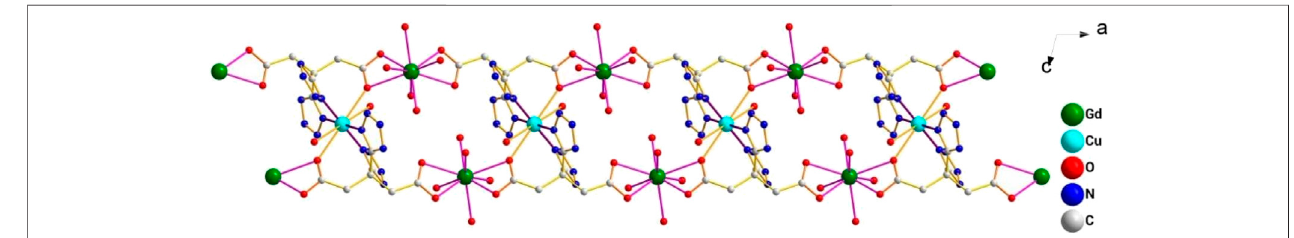
FIGURE 4 | One-dimensional structure of the complex [Gd 2 Cu(L) 2 (H 2 O) 10 ] · 6H 2 O observed along the b-axis direction.